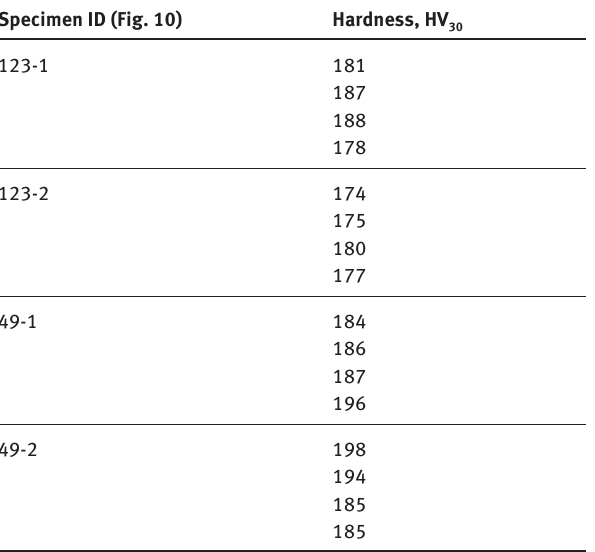
Table 5: Vickers hardness values of reformer tube samples [24]. Specimen ID (Fig. 10)